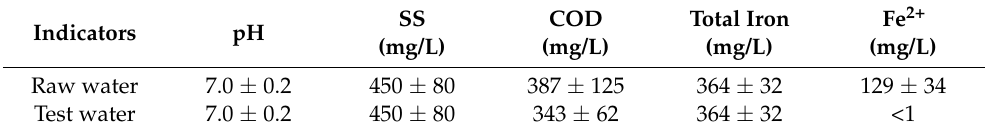
Table 1. Characteristics of anaerobic digestion reject water.